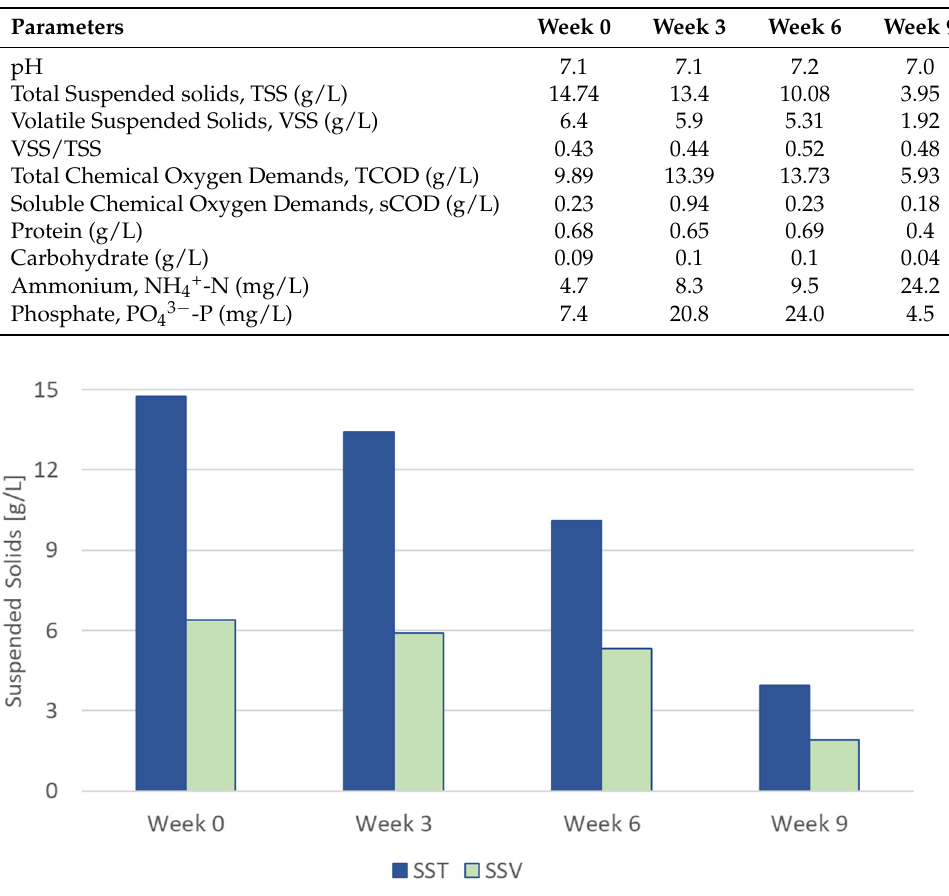
Figure 14. Suspended solids concentrations in the monitored